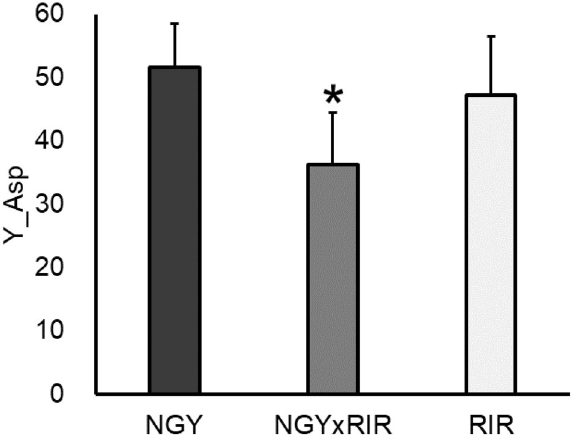
Figure 2. Heterosis effect on yolk aspartic acid trait. NGY, RIR, and their F 1 hybrid (NGYxRIR) were used. Bar indicates standard deviation. One-way ANOVA and Tukey’s HSD test reveals significant effect on negative heterosis ( p < 0.05) as indicated by an asterisk above F 1 hybrid